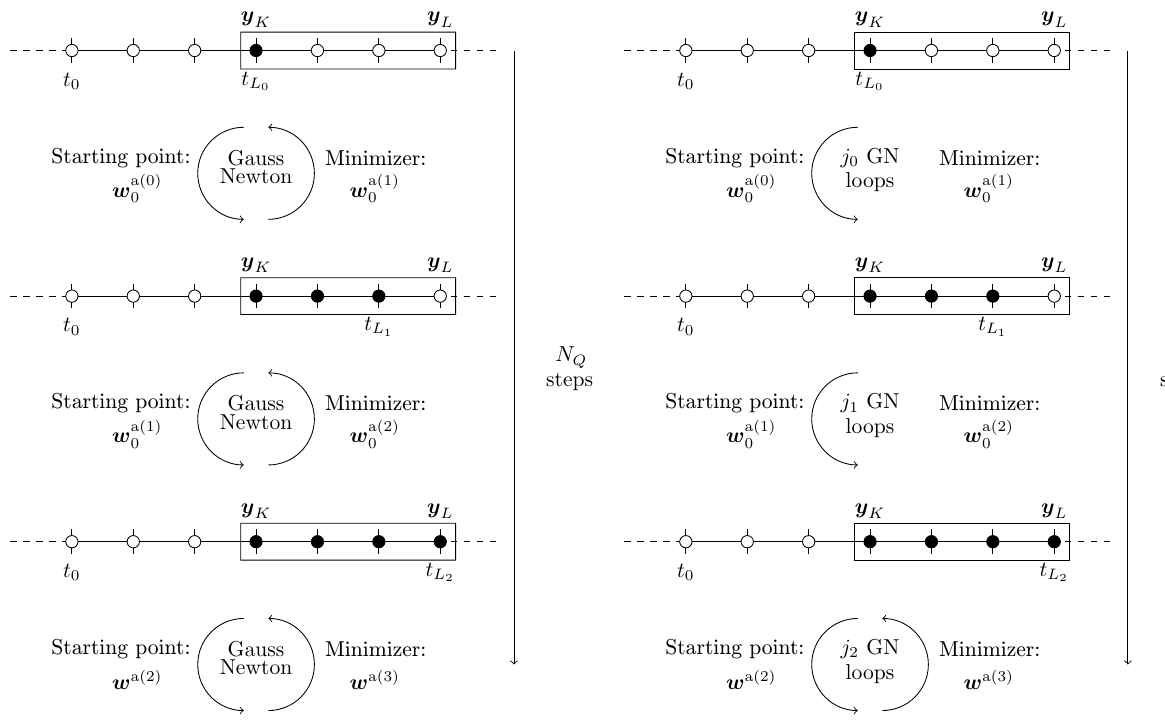
Figure 7. Schematics of an IEnKS QS minimization (a) and an IEnKS QC minimization (b) . The rectangle contains the observations to be assimilated and the black dots represent the observations used in the current minimization. The “Gauss–Newton” surrounded by arrows represents the iterations of the Gauss–Newton procedure. The number of quasi-static steps is N Q = 3. The flow of observations is controlled by the parameters (L 0 ,L 1 ,L 2 ) = ( 3 , 5 , 6 ) . For the QC IEnKS, the number of GN iterations is controlled by the (j 0 ,j 1 ,j 2 )